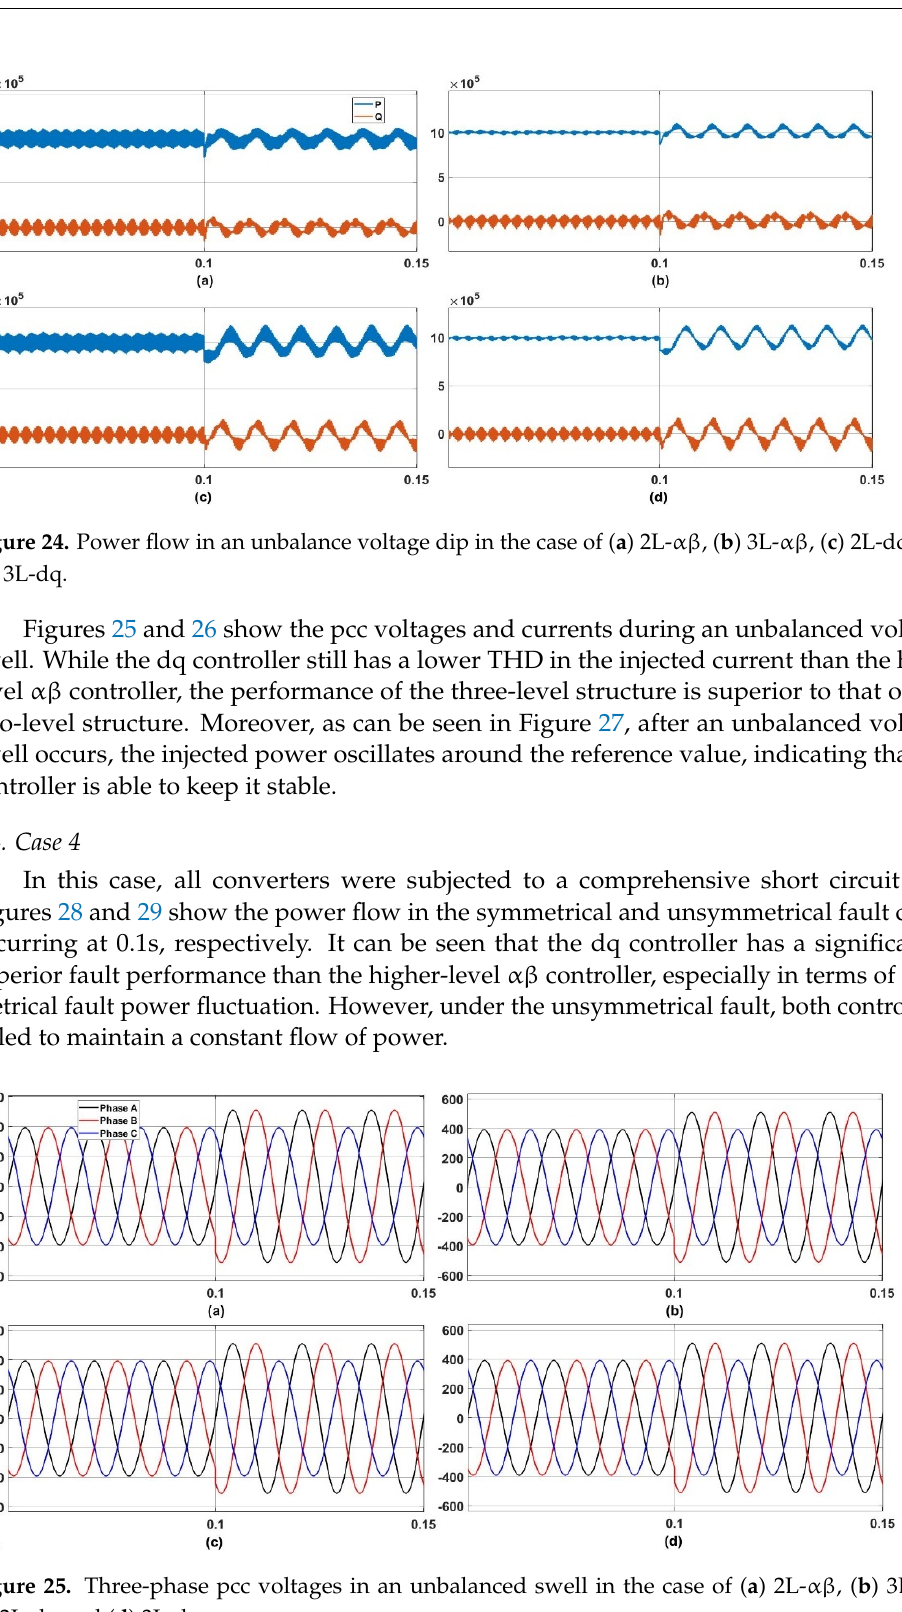
Figure 23. Three-phase pcc currents in an unbalance dip in the case of ( a ) 2L- αβ , ( b ) 3L- αβ , ( c ) 2L- dq and ( d ) 3L-dq .